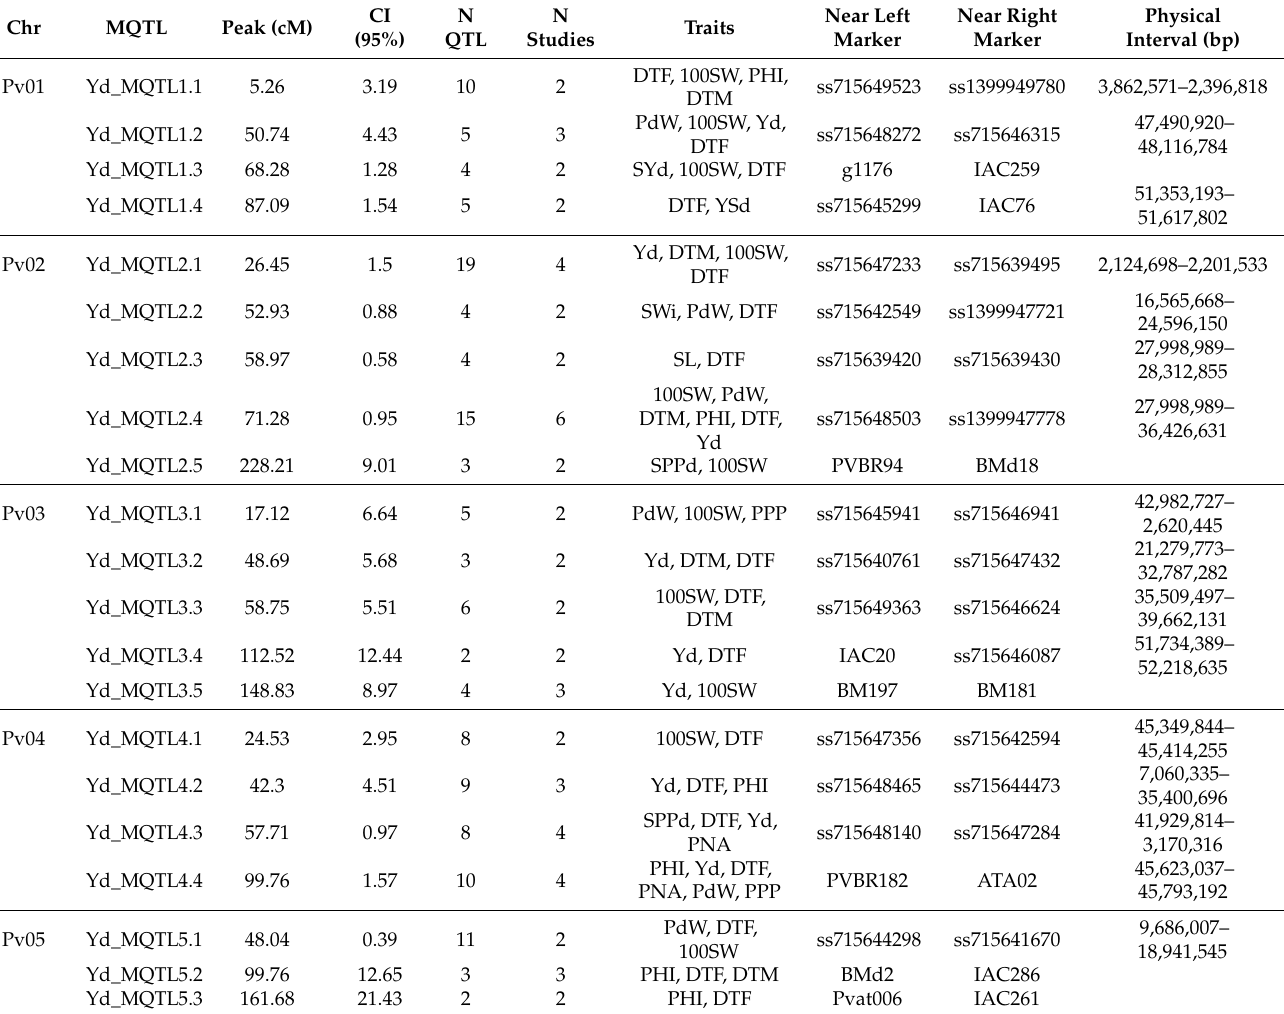
Table 3. Details of 42 Meta-QTL (MQTL) identified for phenological, yield, and yield component in common